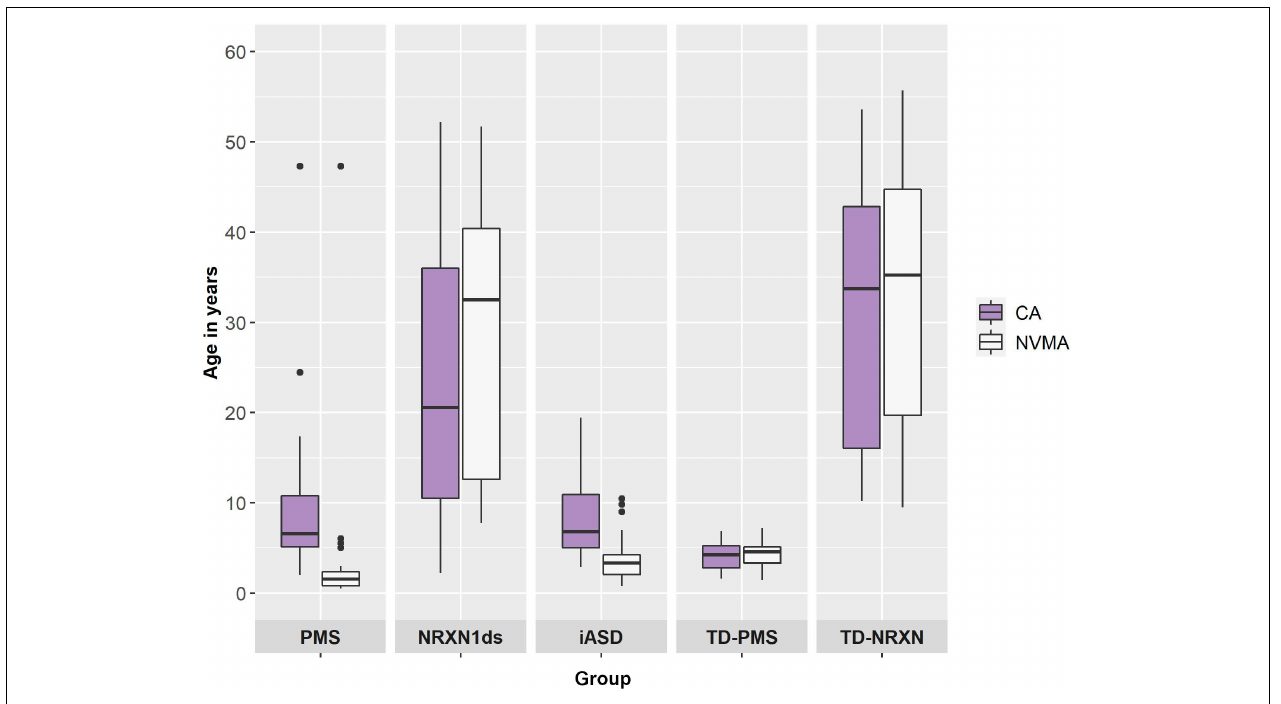
FIGURE 2 | Chronological age (CA) and non-verbal mental age (NVMA) comparisons by diagnostic